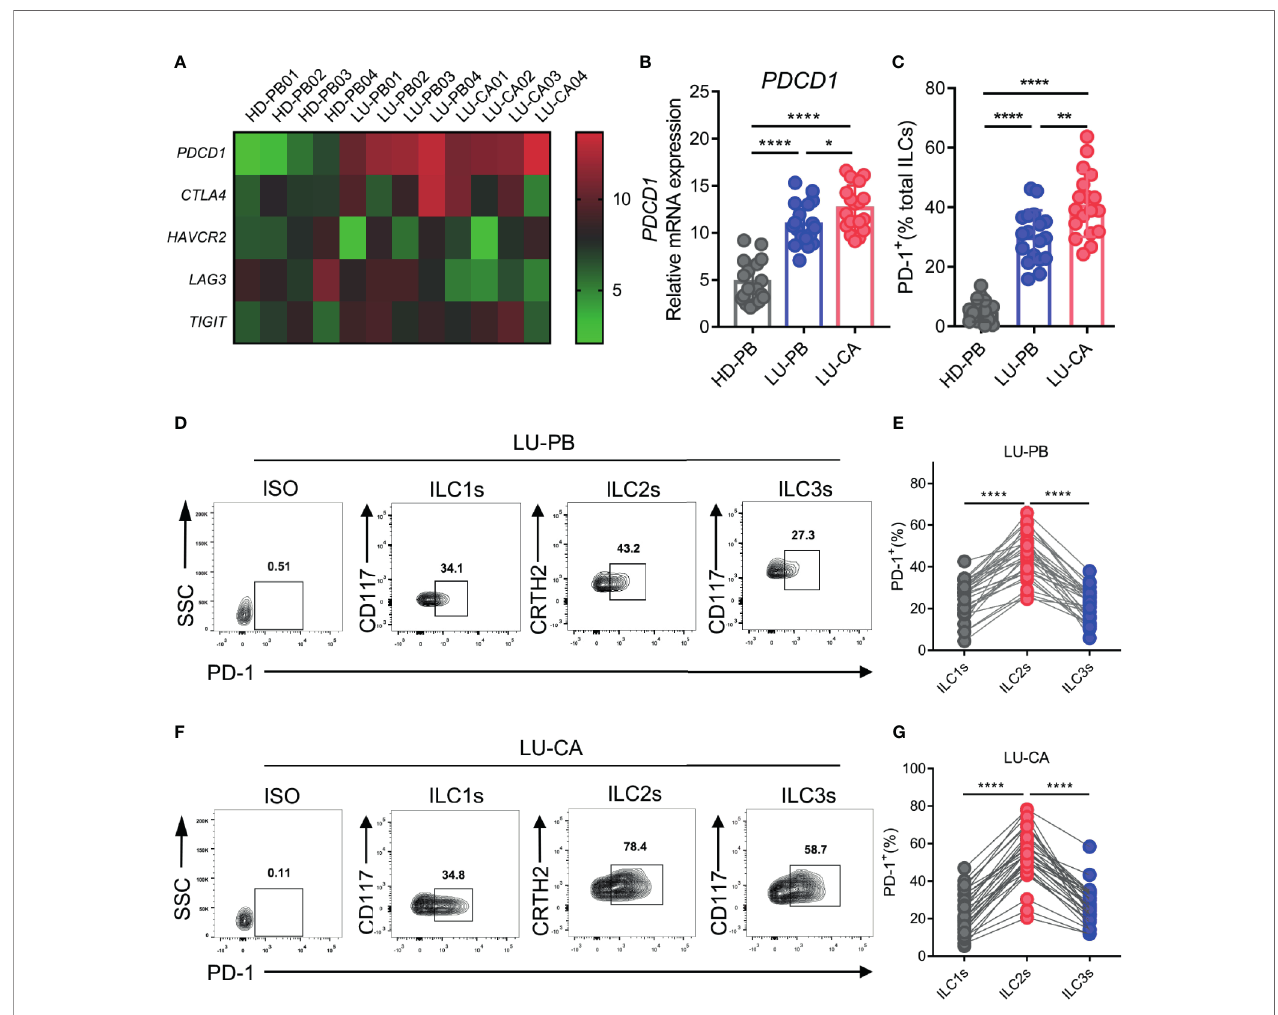
FIGURE 3 | mRNA and protein expression of immune checkpoint molecules of ILC2s. (A – C) The samples of ILC2s used were the same as in Figure 2 . (A) The heatmap showing relative mRNA expression of PDCD1 , CTLA4 , HAVCR2 (encoding TIM3), LAG3 , and TIGIT on ILC2s in HD-PB, LU-PB, and LU-CA samples. (B) The relative mRNA expression of PDCD1 on ILC2s from HD-PB, LU-PB, and LU-CA samples (for each group, n=18). (C) The protein expression of PD-1 on total ILCs obtained from HD-PB, LU-PB, and LU-CA samples (for each group, n=18). (D – G) The representative results and statistical results of PD-1 protein expression on ILCs subsets in LU-PB (D, E) and LU-CA (F, G) assessed by fl ow cytometry (for each group, n=30). * P <0.05, ** P <0.01, **** P <0.0001. P values were calculated by one-way ANOVA and post hoc comparisons were performed via Tukey ’ s